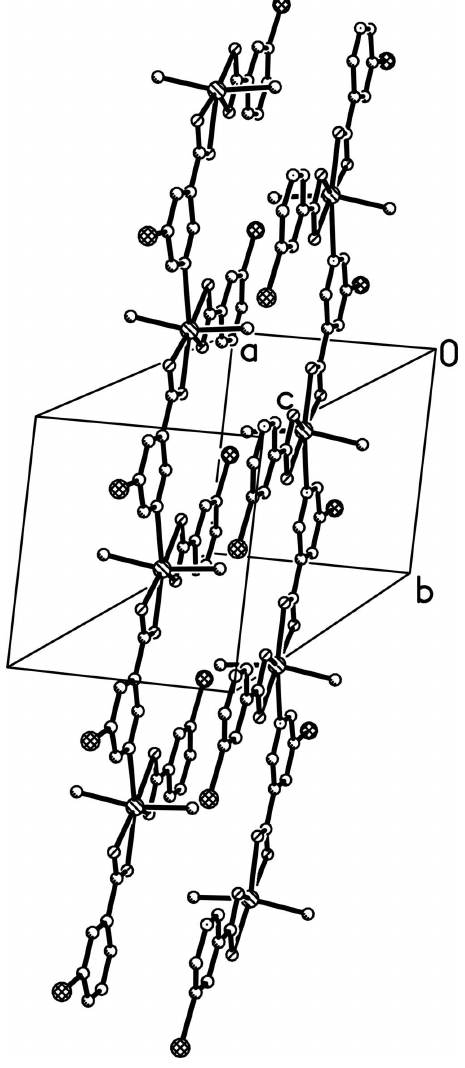
Figure 2 Polymeric chain formation in (I). H atoms omitted for clarity. catena -Poly[[(5-bromopyridine-3-carboxylato)dimetyltin(IV)]- µ -5-